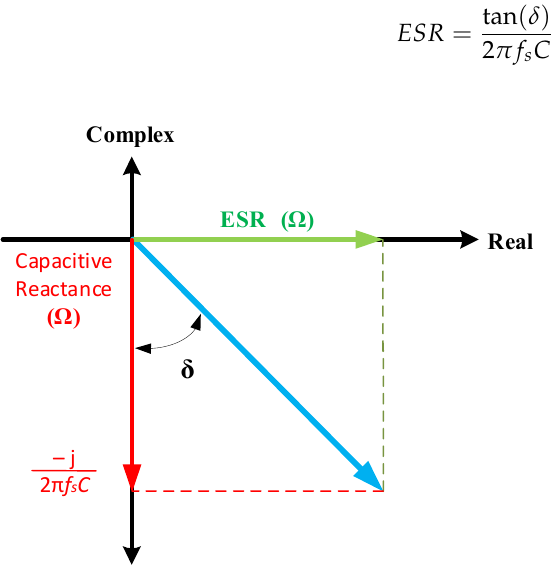
Figure 13. Representation of the loss angle of a capacitor.